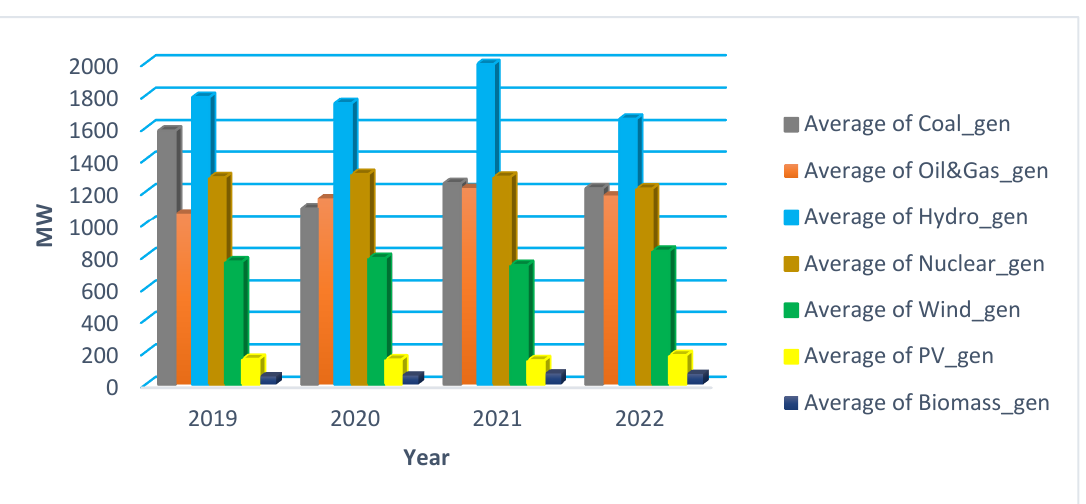
Figure 5. Average electricity consumption and generation between 2019 and 2022 in Romania. The generating units based on resource type distribution that covered the load year by year from 2019 to 2022 are depicted in Figure 6. Both non-RES (nuclear, coal, oil and gas) and RES (including hydro) contributed to supply the consumption (as in Figure 6).